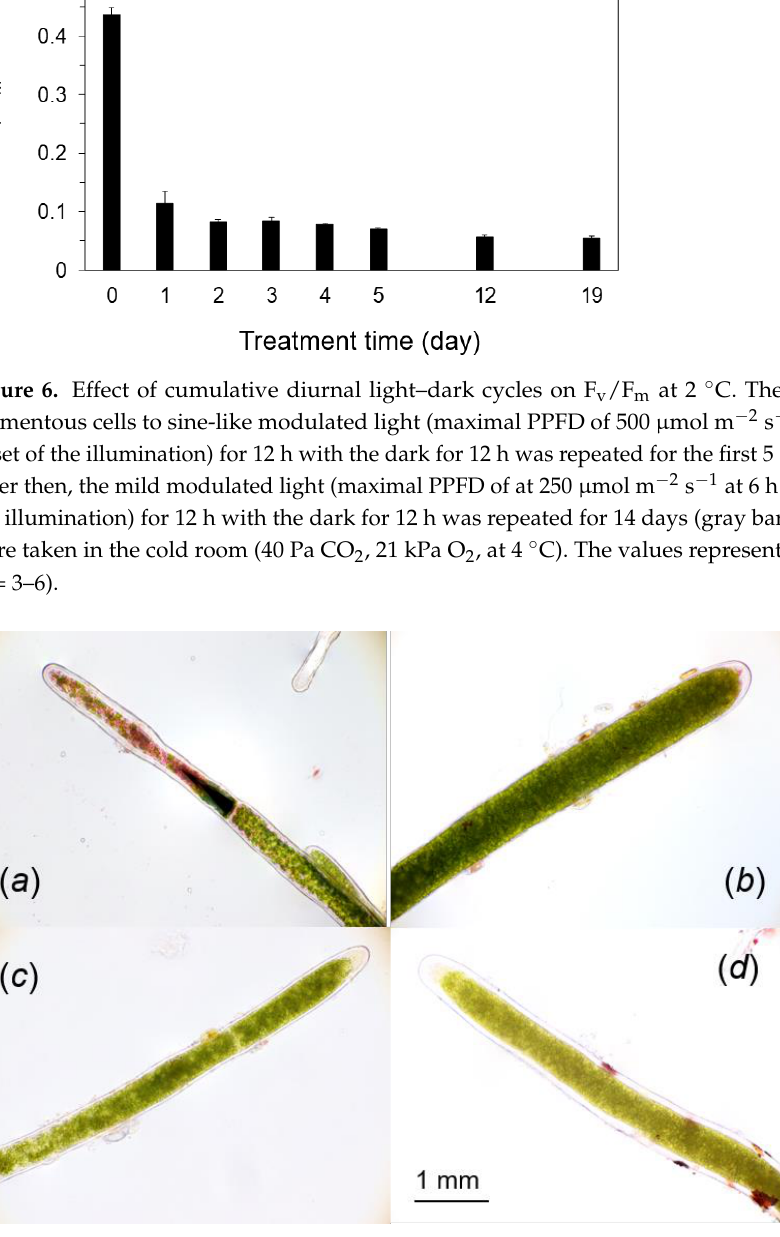
Figure 7. Filamentous cells of marimo used in Figure 6 with neutral red uptake assay. ( a ) Non- damaged cells incubated in the dark as a control. ( b ) Photoinhibited cells after five days of the high modulated light. ( c ) Cells treated with the repair light for 7 days after the high light for 5 days and ( d ) 14 days.